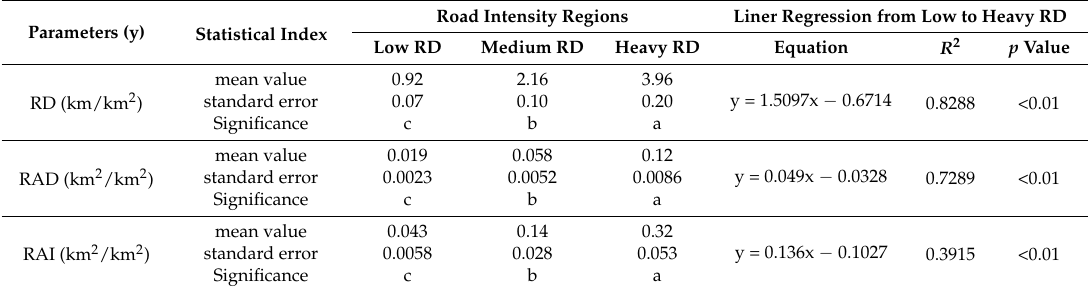
Table 2. Characterization of the study object at different density